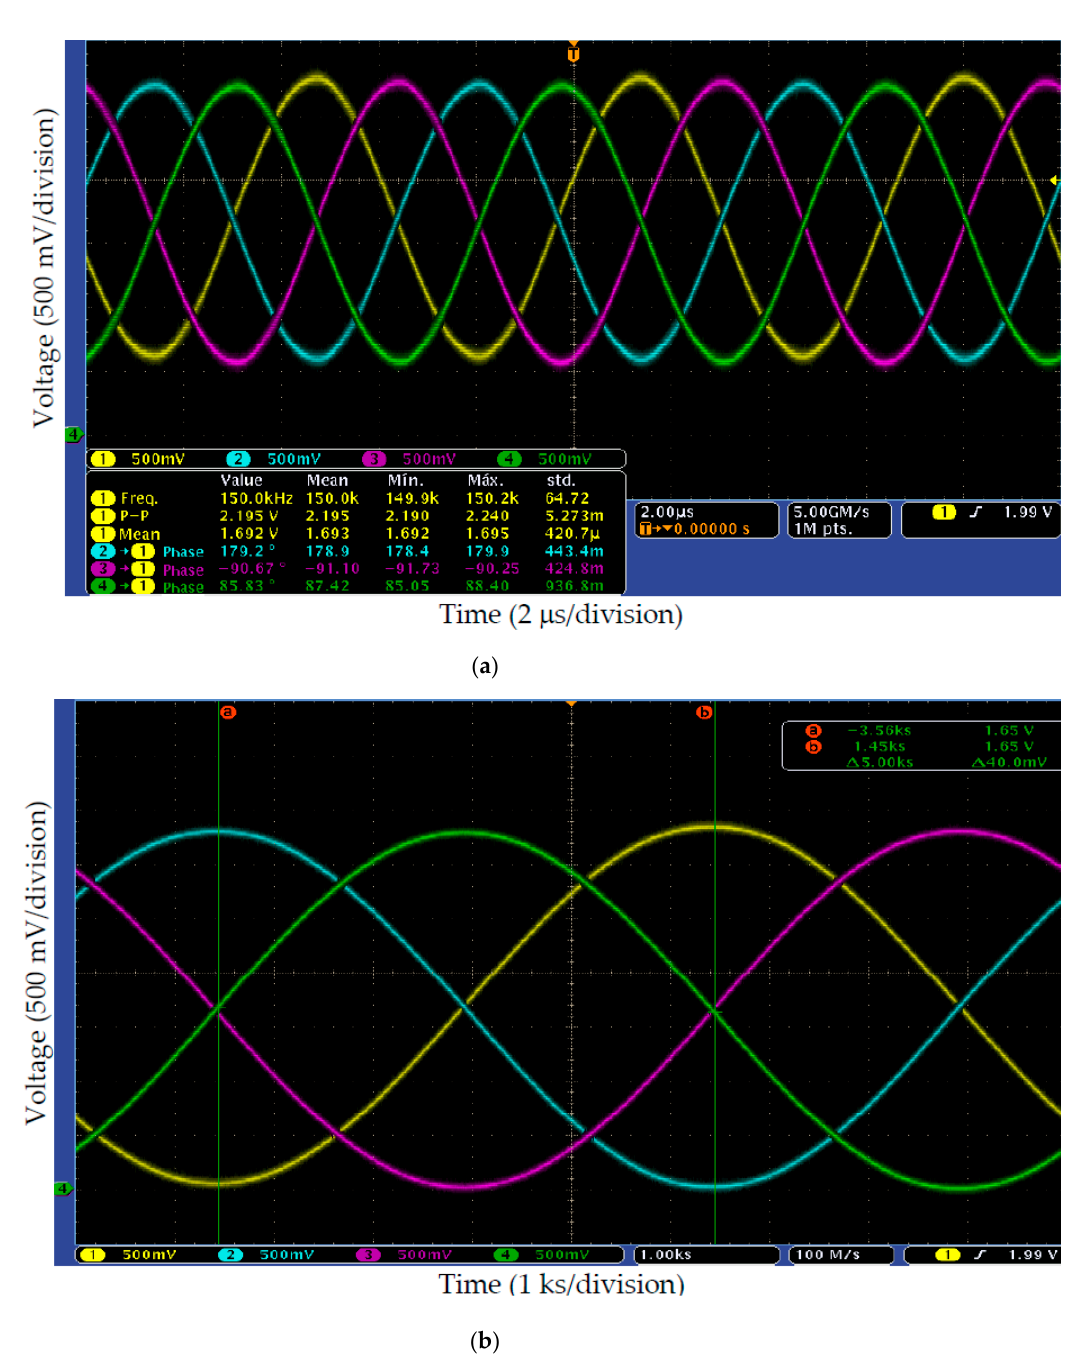
Figure 9. Quadrature sinusoidal signals (voltage versus time) provided by the proposed ∆ modulation Digital-to-Analog Converter (DAC) using the same LPF, for ( a ) 150 kHz, and ( b ) 100 mHz. Because the adder provides both the carry and its negated value, a core can provide two quadrature signal pairs in parallel.